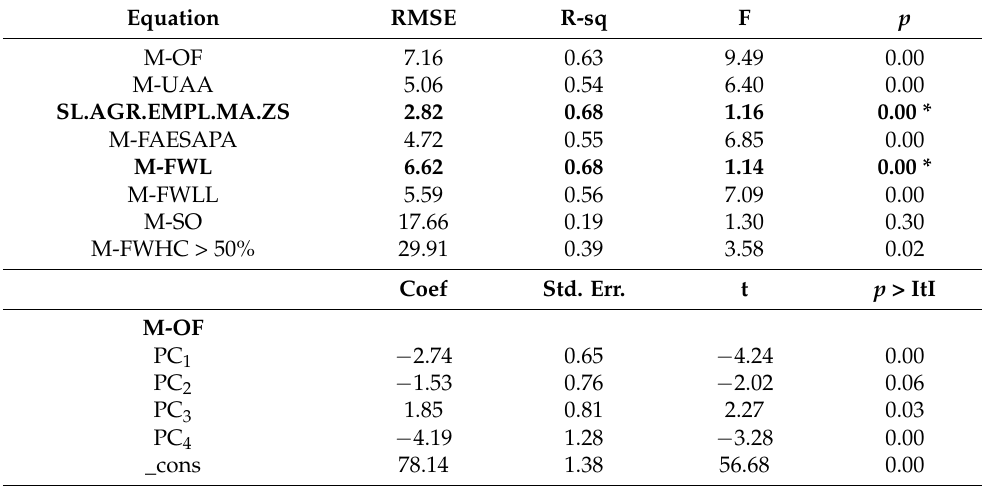
Table 9. Estimate of coefficients of the multivariate regression